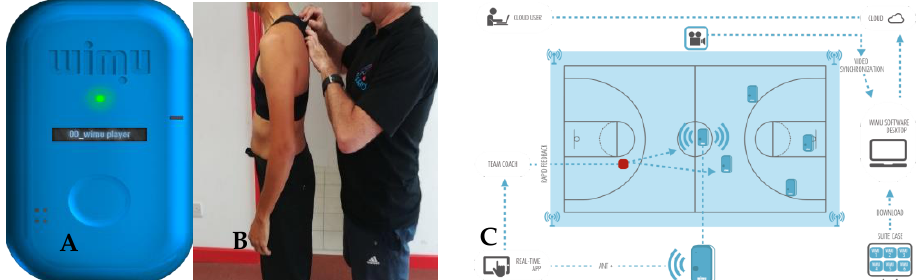
Figure 1. A: WIMU PRO TM (wireless inertial unit movement) ready to use; B: Introduction of the WIMU PRO device on a specific harness; C: The antenna system’s placement (All appropriate permissions have been obtained from the copyright holders as well as written informed consent from the depicted individuals for the publication of this image).